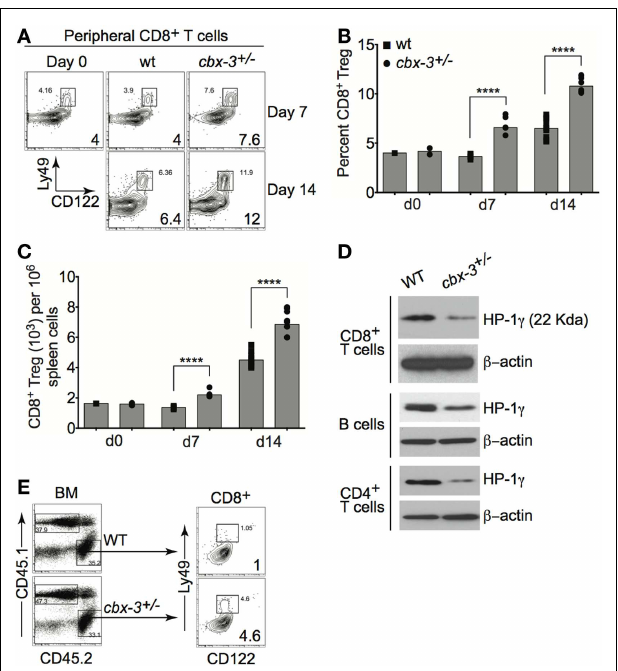
FIGURE 7 | CD122 + Ly49 + CD3 + CD8 + regulatoryT-cell compartment is expanded in cbx-3 + / − mice . (A) On days 7 and 14 after immunization, percent of spleen CD122 + Ly49 + CD3 + CD8 + regulatoryT-cell (T reg ) population from wt littermate and cbx-3 + / − mice was assessed by FACS. Numbers in lower right corners indicate percent cells. CD122 + Ly49 + CD8 + T reg cells were gated on the CD3 + population. (B,C) Plots represent a compilation of the percent and number of CD8 + T reg population from (A) . Each symbol denotes an individual mouse. Bars represent median. Statistical analysis was performed with GraphPad one-way ANOVA. Day 7, n = 5 for each genotype; **** p < 0.0001. Day 14, n = 8–12 for each genotype; FIGURE 6 |The GC reaction defect in Cbx-3 + / − mice is not intrinsic to **** p < 0.0001. (D) Purified CD8 + CD44 − , CD4 + CD25 − , and CD43 − B cells B orT FH cells . (A) cbx-3 + / + /cbx-3 + / − mixed bone marrow chimeras were were collected from spleen and peripheral lymph nodes. Blots were probed generated in B6- Rag2 − / − c γ − / − recipients at a 1:1 ratio of either CD45.1 with anti-total HP-1 γ (22kDa) and anti- β -actin (42kDa). Results are cbx-3 + / + /CD45.2 cbx-3 + / + or CD45.1 cbx-3 + / + /CD45.2 cbx-3 + / − bone marrow. representative of two independent experiments; n = 4 mice of each Eight weeks after reconstitution chimeric mice were immunized with genotype. (E) cbx-3 + / + /cbx-3 + / − mixed bone marrow chimeras were NP-CGG in alum. (B) On day 14, spleens were analyzed to determine the generated as in Figure 6A . Percent CD8 + T reg cells were determined by frequency of GC B cells, switched IgG + B cells andT FH cells derived from FACS. Numbers in lower right corners indicate percent cells. CD45.1 1 CD45.2 (control cbx-3 + / + or cbx-3 + / − ) donor bone marrow in each mouse. Numbers in bottom left corners of FACS plots indicate percent GC B cells. Numbers in bottom right corners denote percentT FH cells. CD45.1 and CD45.2 populations were derived from the lymphoid gate. GC and IgG + B 1 cells were derived from the B220 + gate. CXCR5 hi PD-1 hi T FH cells were gated on theTCR β + CD4 + population.